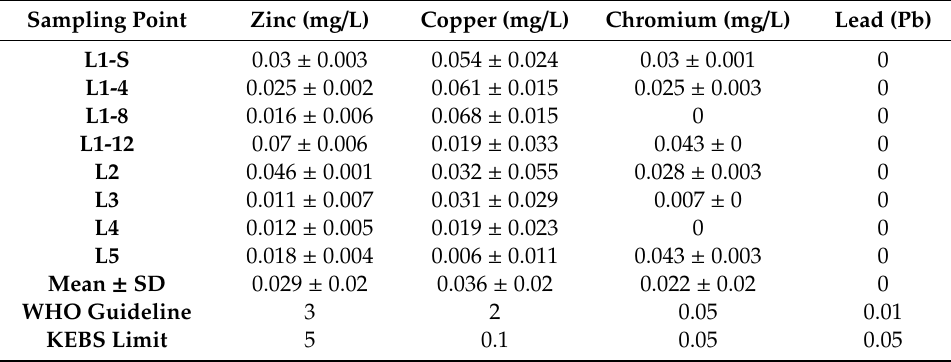
Table 11. Concentration of heavy metals in Rungiri quarry reservoir in January 2019. Sampling